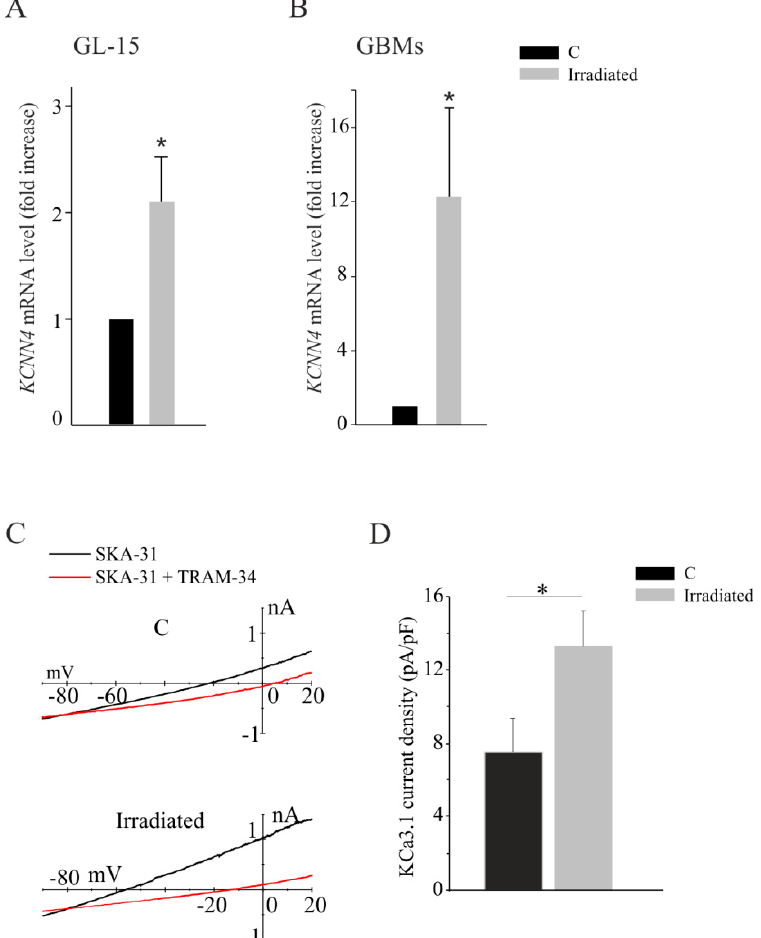
Figure 1. ( A , B ) Expression analysis by qRT-PCR of KCNN4 mRNA in GL-15 cells ( A ), in patient-derived primary glioblastomas (GBMs) (GBM18, GBM19, and GBM45) ( B ) after 1 cycle of radiation (35 Gy). ( A ) * p < 0.05 vs. control (C) GL-15; ( B ) * p < 0.05 vs. respective controls (C), n = 3 (in